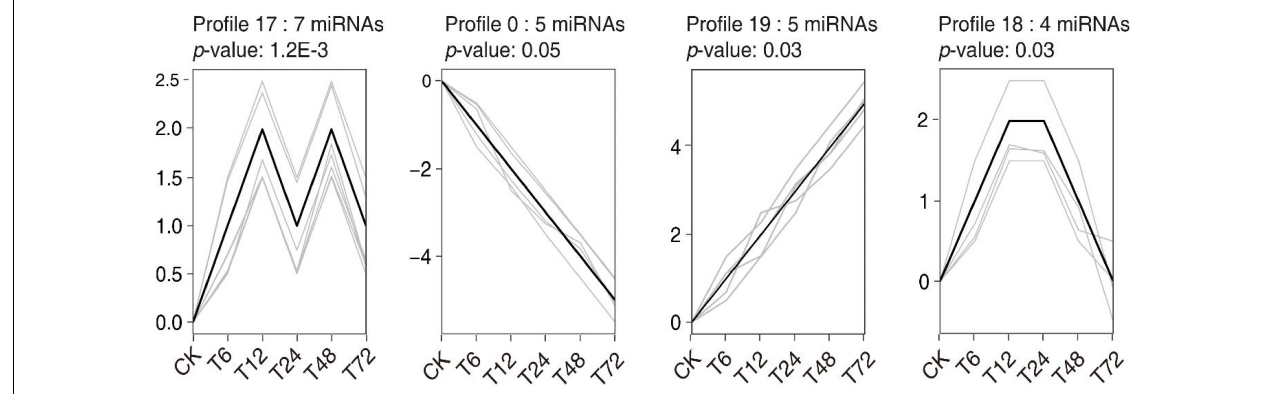
FIGURE 4 | Significant expression trend profiles (with the cut-off criteria of p ≤ 0.05) for DEMs in sugarcane roots after low-K + treatment. The x-axis represents time after low-K + treatment, from 0 to 72 h. The y-axis corresponds to log2 fold changes in miRNA